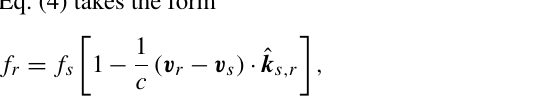
Figure 1. Schematic presentation of the McRALI-FR simulator. Once the simulation conditions are defined (step 1), McRALI calculates the idealized backscatter spectrum (step 2). In the last step (step 3), using dedicated software, the desired quantity profiles are calculated. Note that cloud extinction between 9 and 10km of altitude is set to 3km − 1 for both the lidar and radar simulation. Eq. (4) takes the